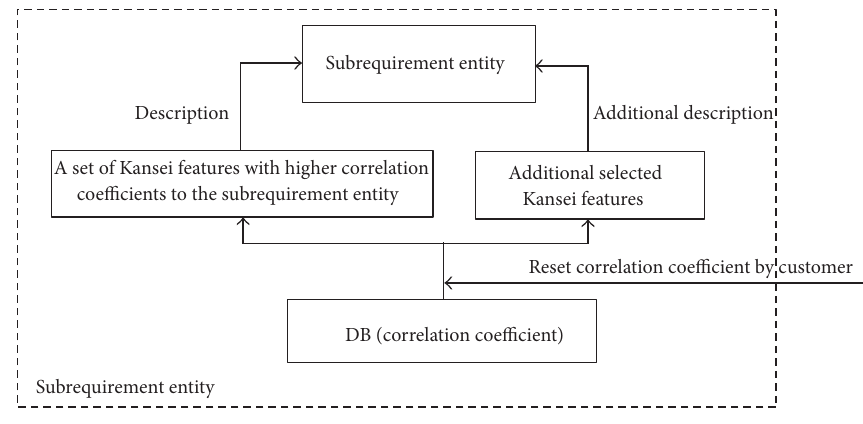
Figure 5: Interior of a subrequirement